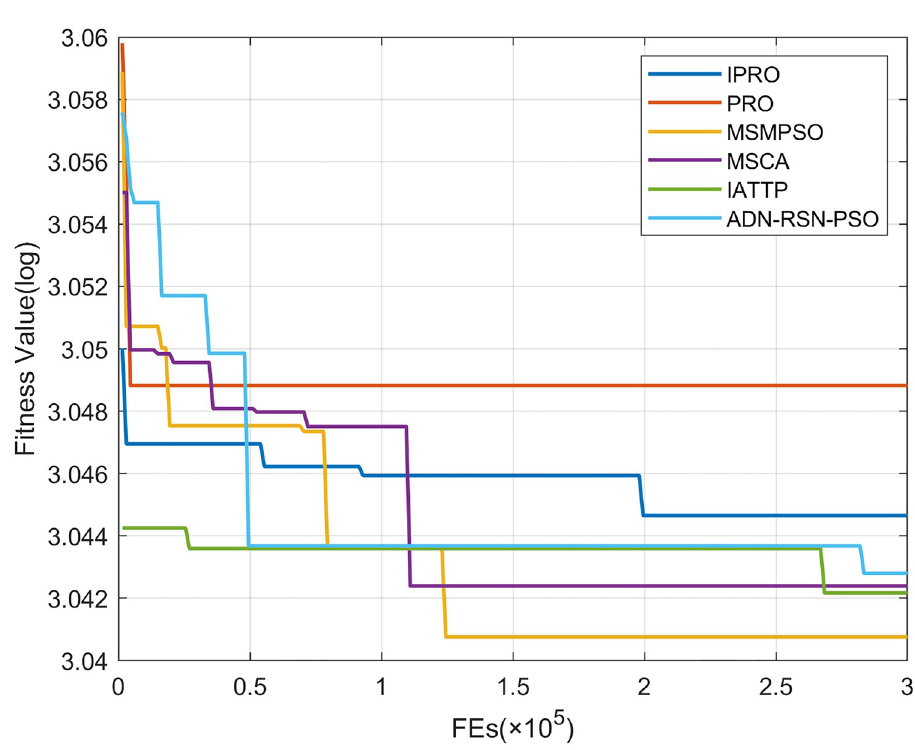
Fig 8. Convergence curves on